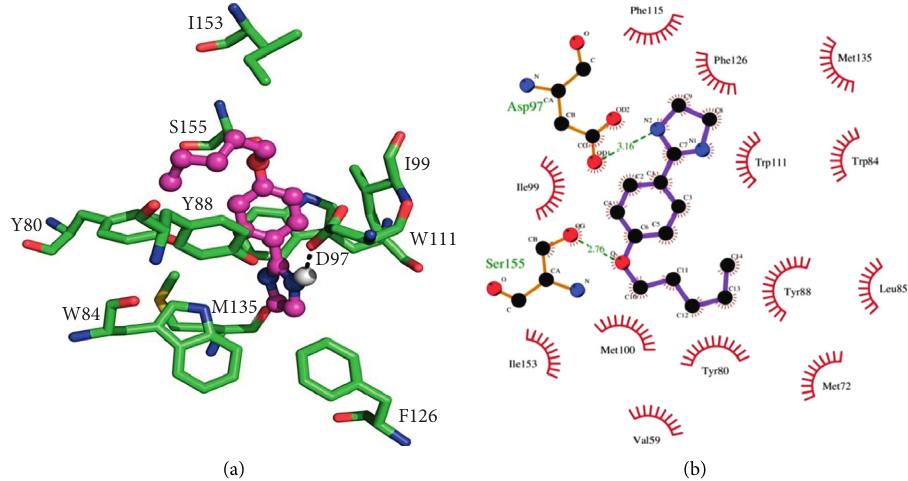
Figure 8: The noncovalent interaction of 13 with CviR. The ligand-protein interaction is illustrated (a) in 3D and (b) in a 2D schematic diagram. Hydrogen bonds are depicted with a dotted green line, indicating the bond distance in ˚A ( 3.28 ). The hydrophobic residues of the protein in contact with the ligand are portrayed by red semicircles and radiant lines: Phe115